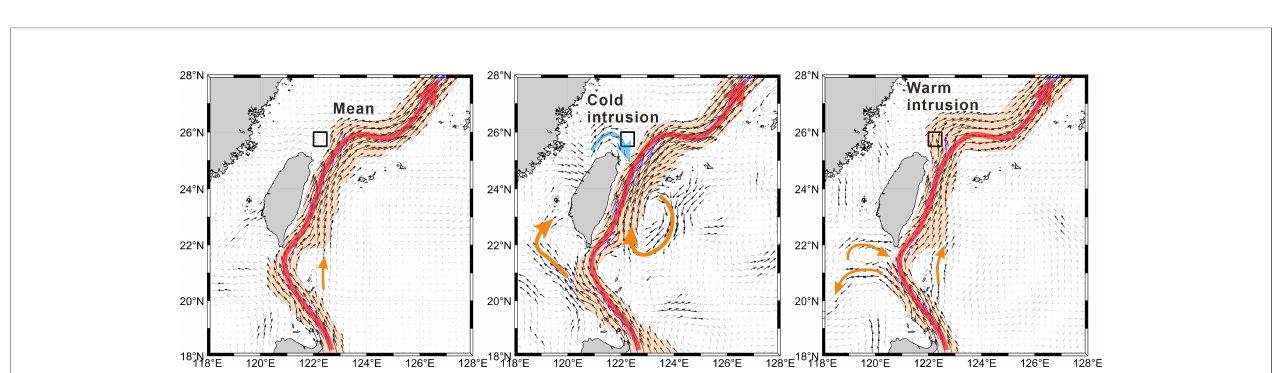
maximum velocity position of the Kuroshio. The absolute geostrophic velocity in the transparent orange shading region is ≥ 0.2 m s − 1